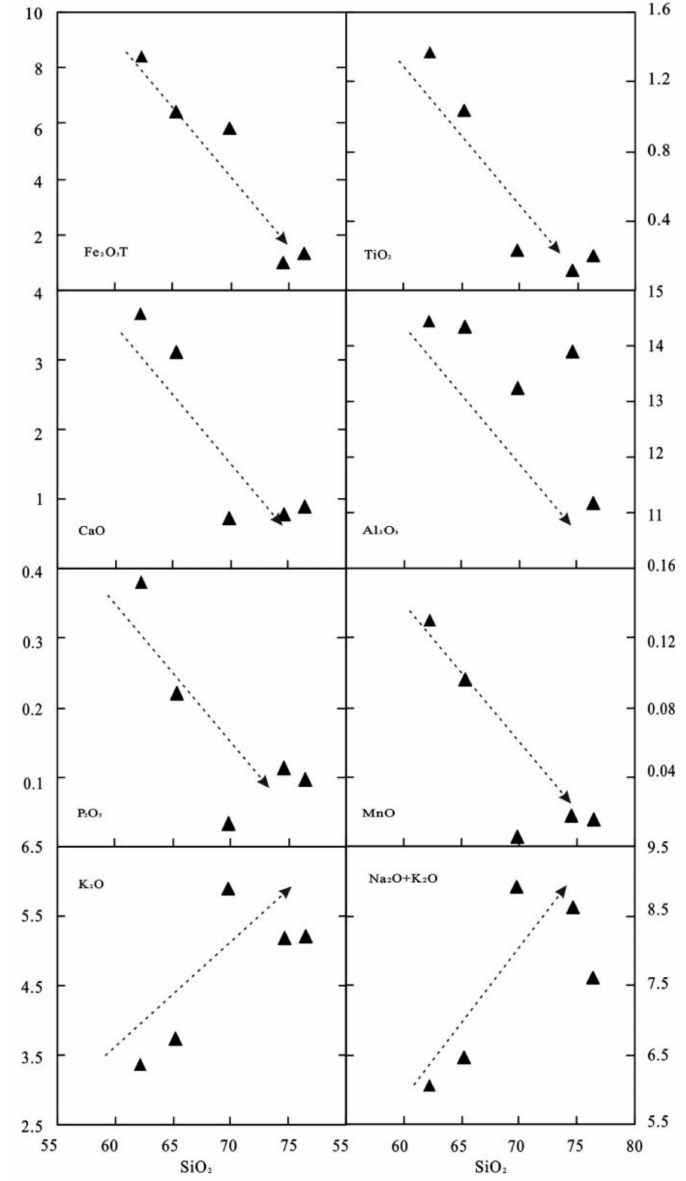
Figure 6. Harker variation diagrams for biotite granite samples. Table 3. Major (oxide wt%) and trace (in ppm) element contents of biotite granites in the Gaudeanmus area.